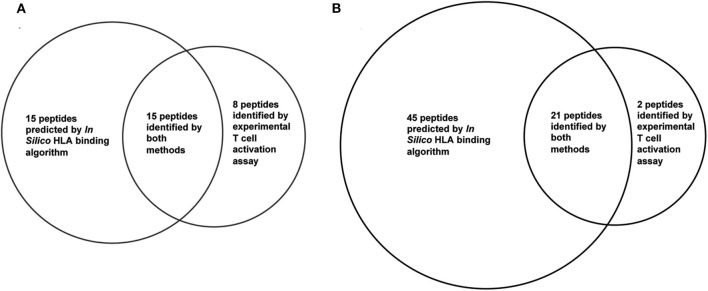
Overlap of experimental T cell epitopes and in silico HLA binding prediction. Twenty three T cell epitope were identified in PE38 by experimental T cell activation assays using 50 PBMC donors. In silico predicted binders in PE38 were predicted using the IEDB consensus HLA class II binding algorithm and 15 HLA-DR alleles. A peptide was considered a potential epitope using a threshold of (A) top 30 predicted binders and (B) top 56 predicted binders (50%). Peptides 8 and 9 were false negatively predicted using both thresholds.